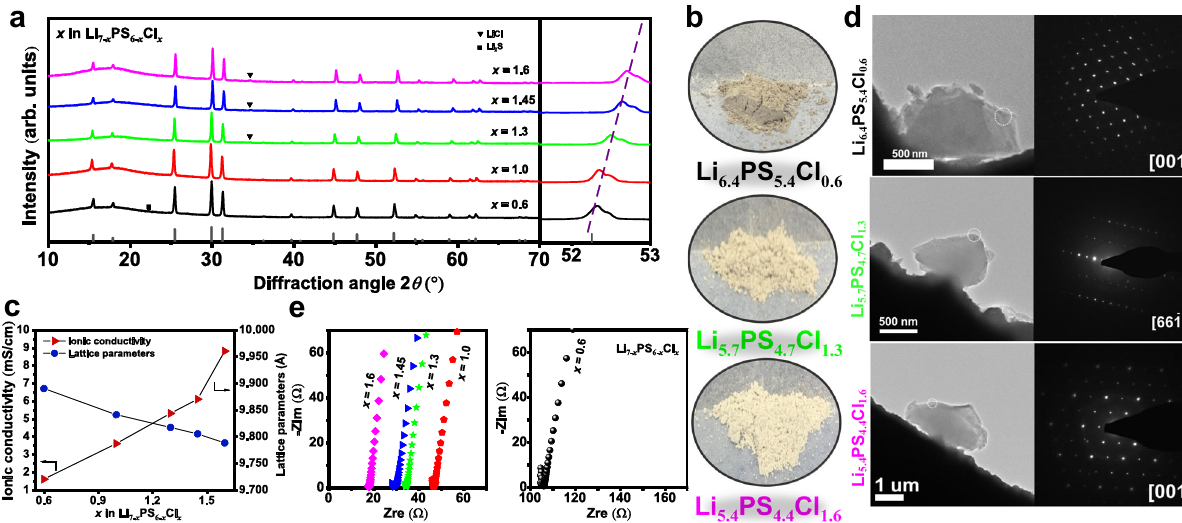
Fig. 1 Structure and ionic conductivity analyses for Li 7 − x PS 6 − x Cl x argyrodites. a X-ray diffraction patterns of annealed samples. b The color of the powders for selected samples. c Chlorinity dependence of the ionic conductivity and lattice parameters. d TEM images of Cl-06, Cl-13, Cl-16, and the corresponding SAED patterns. e Complex impedance plot of selected frequencies for measurements carried out in In|SE|In cell con fi guration at 24